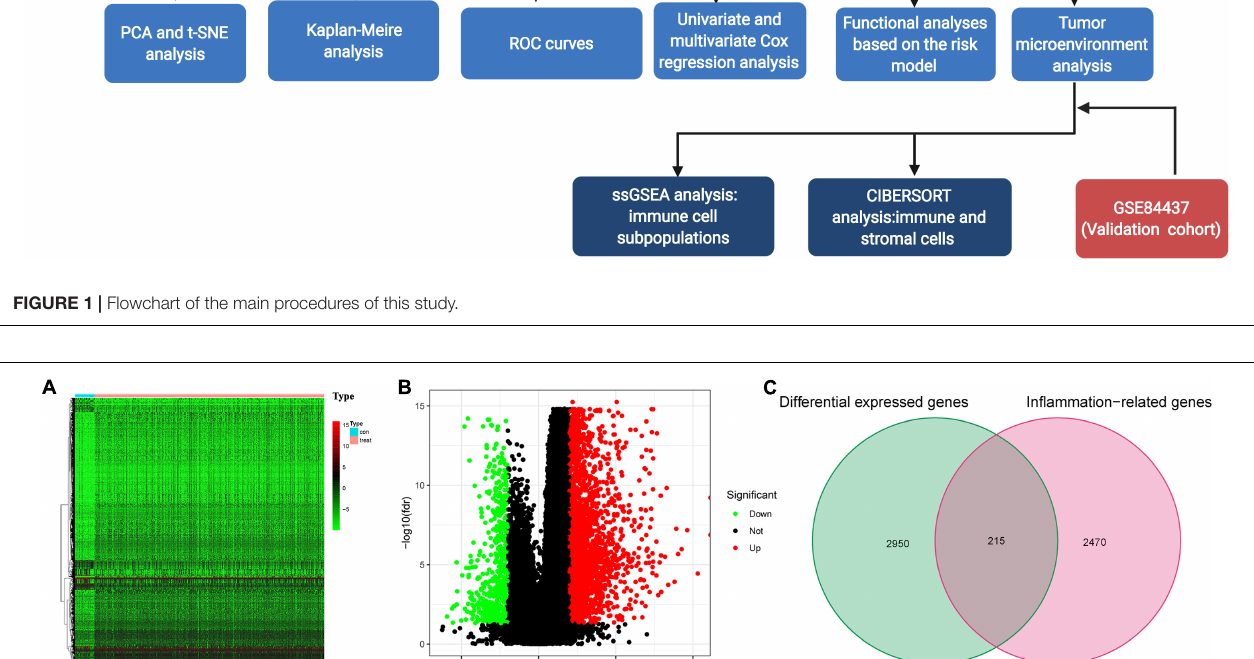
Frontiers in Medicine |